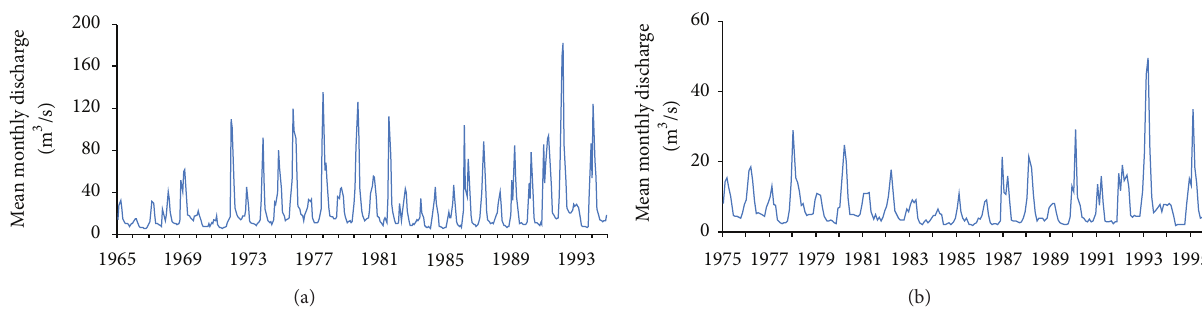
Figure 2: Time series mean monthly discharge at (a) Chamriz station from 1965 to 1995 and (b) Dehkadeh-Sefid station from 1975 to 1995.